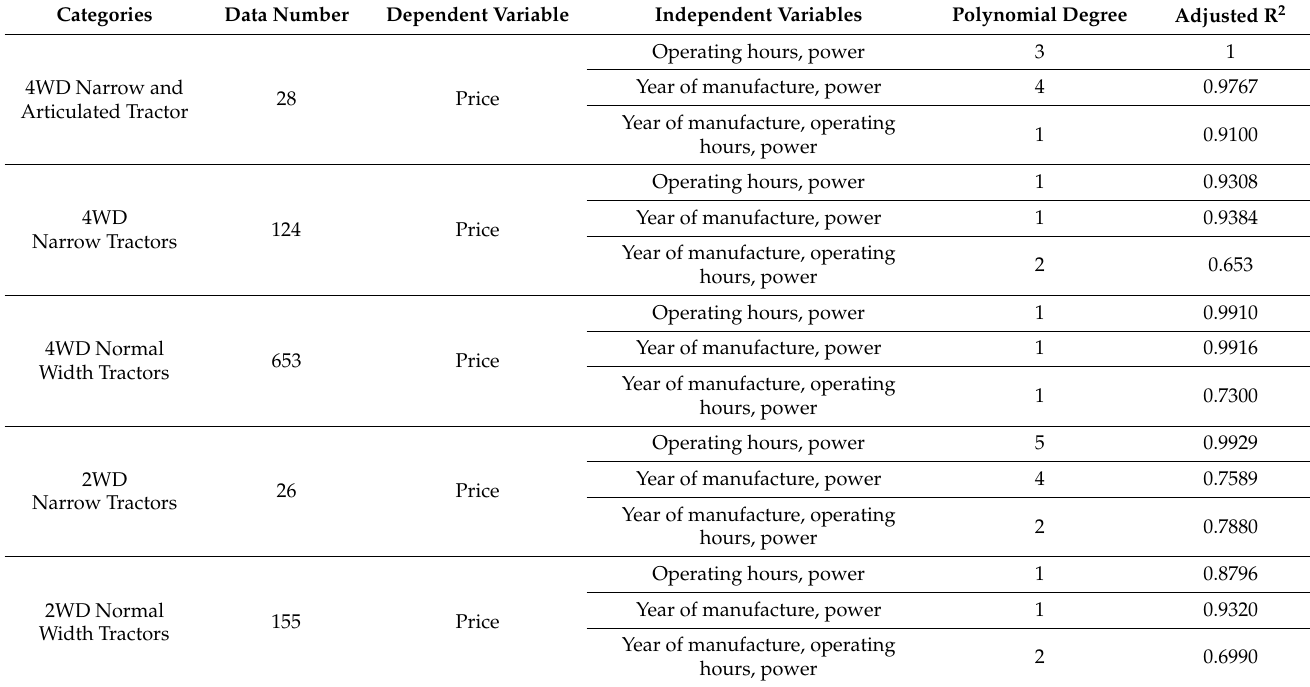
Table 13. Summary of results performing segmentation by official category in second-hand